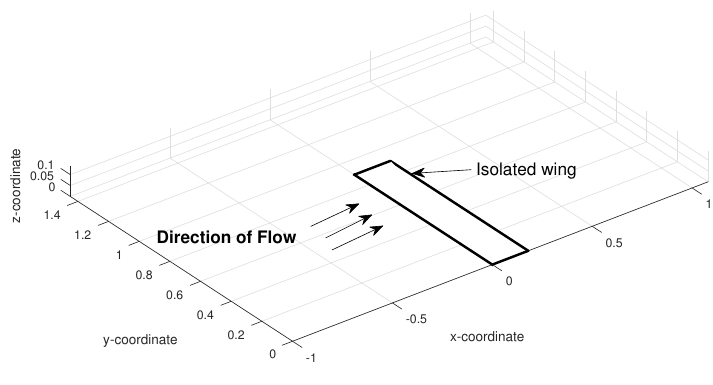
Figure 3. Schematic of isolated wing NACA23012 and spatial domain within the VLM